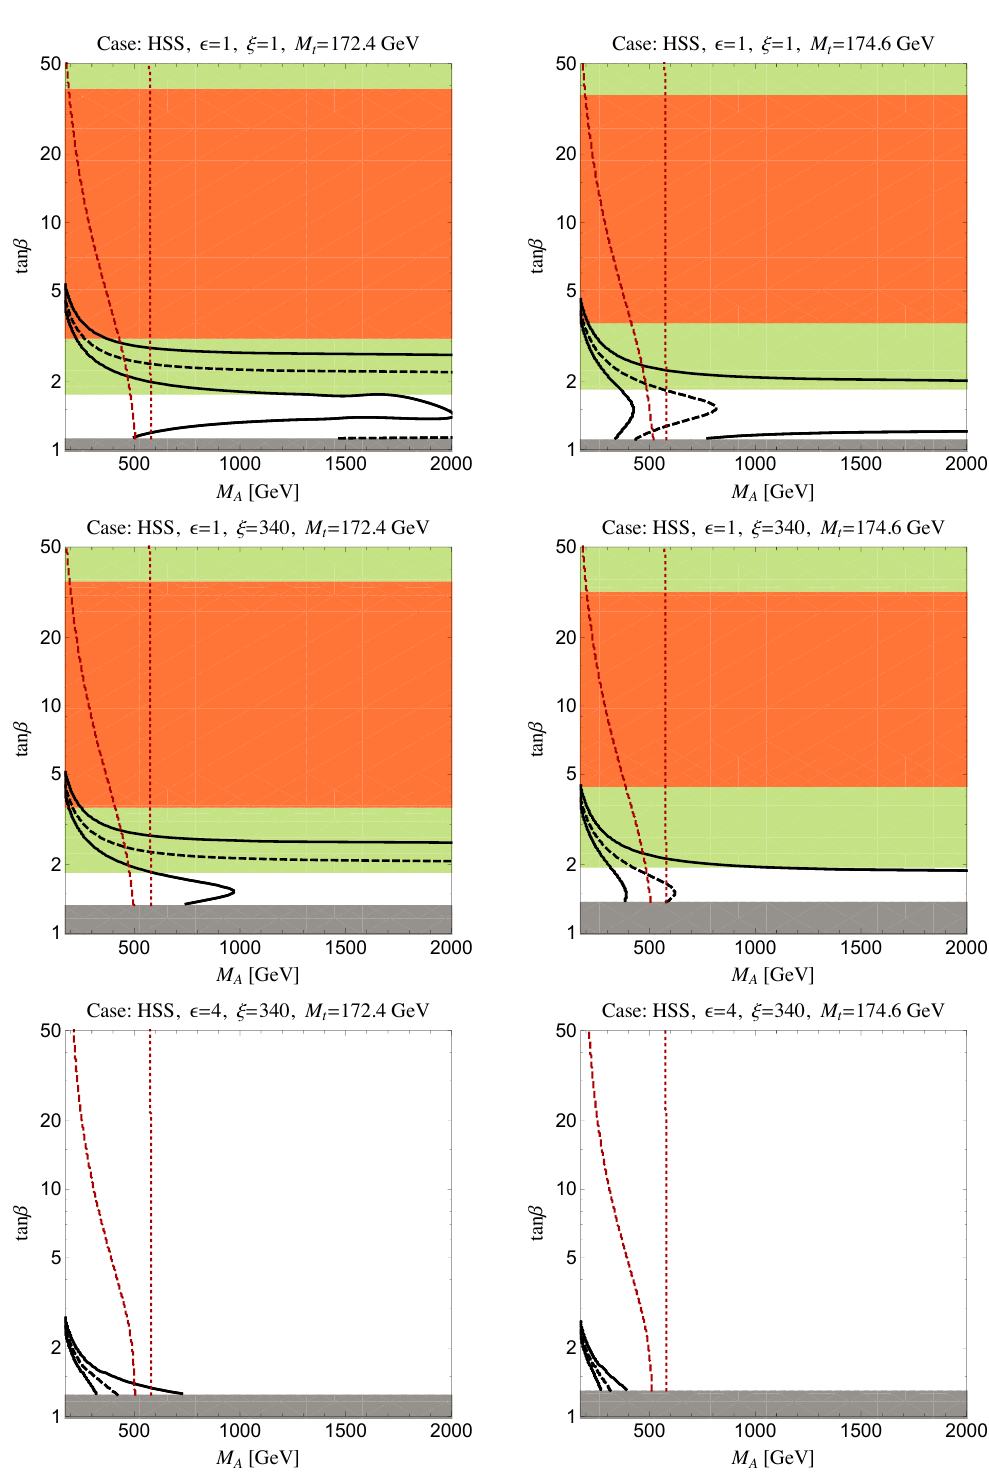
Figure 7 . The details are same as given in the caption of (cid:12)gure 1. For all the cases, N = 2 : 07.